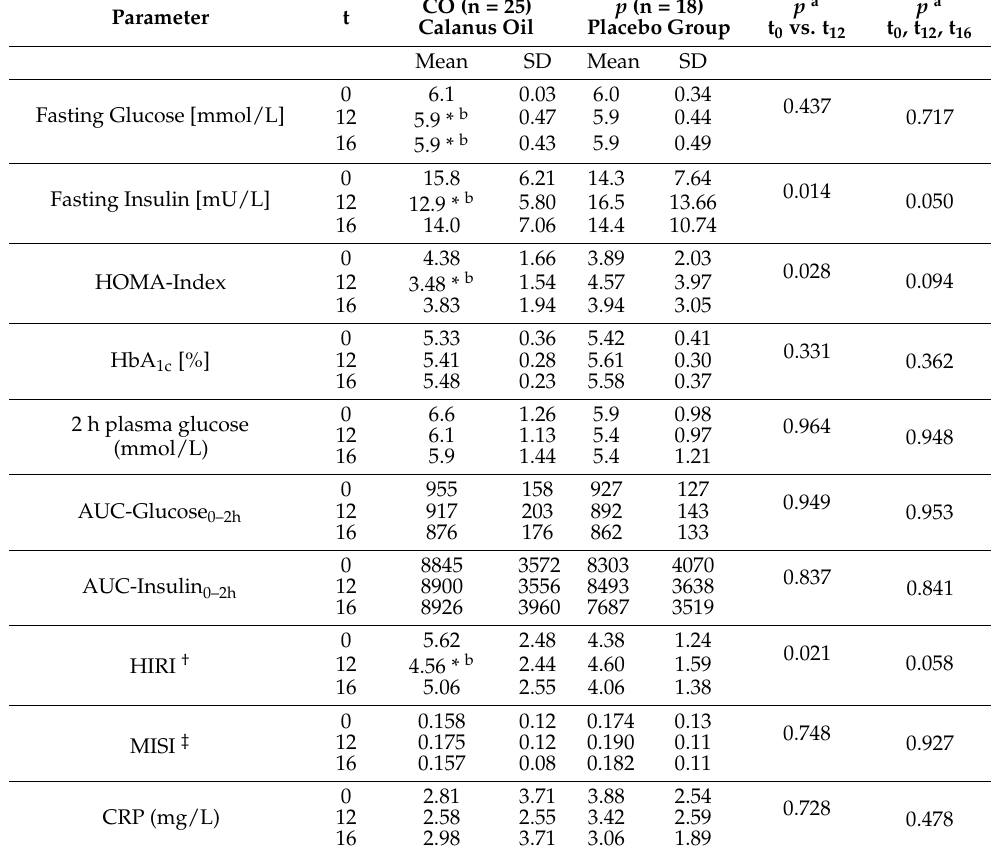
Table 3. Effects of Calanus oil on markers of glucose metabolism and